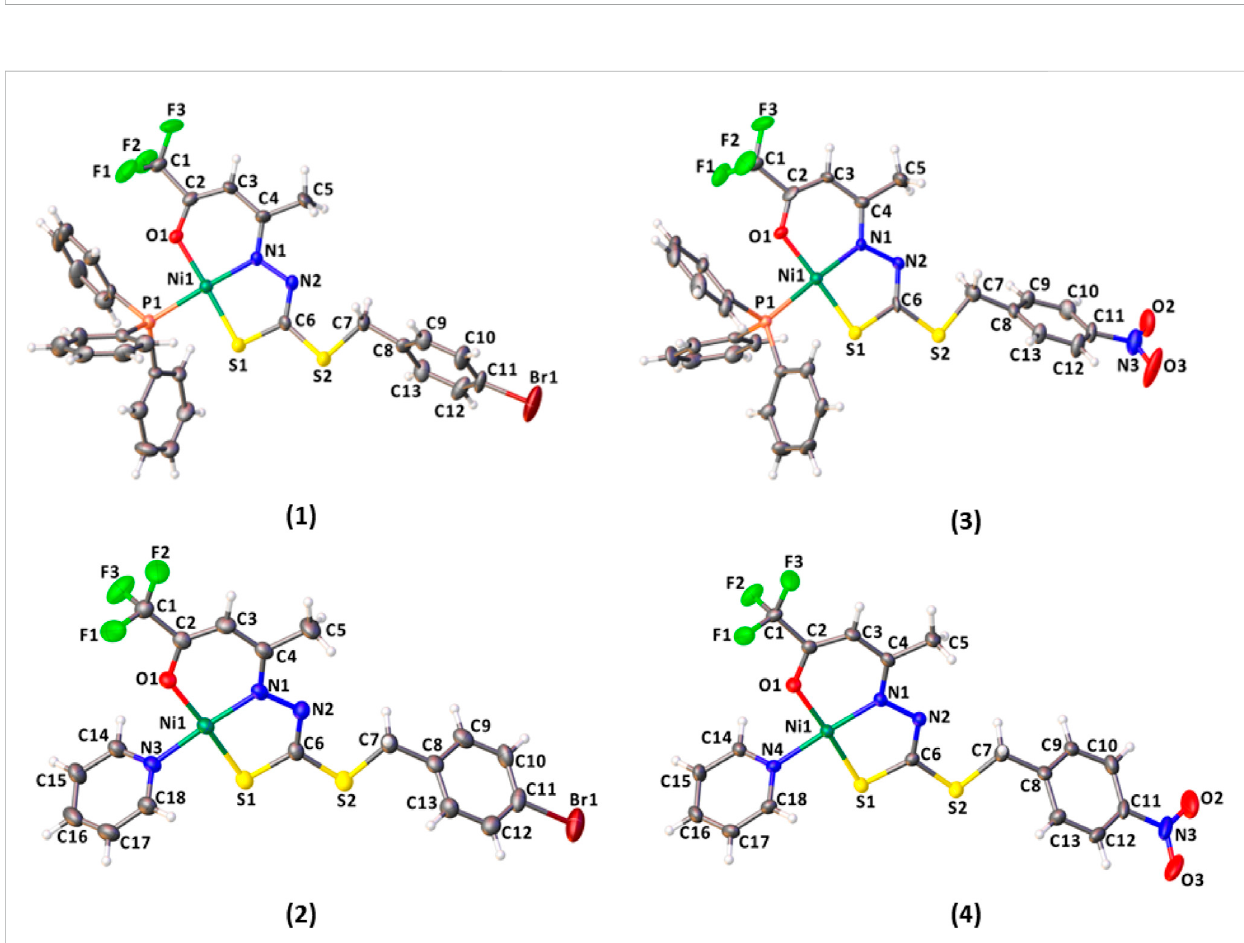
docking study was taking the population size as 100, performing 200,000 operations, and fi xing the mutation frequency as 10 with the crossover mutation frequency. As a result of our pre-docking study, using the redock methodology, we obtained the RMSD between the best- fi tted docked pose and the crystallographic coordinates of the original ligands established as 0.2 Å for the UDP ligand (4KCG